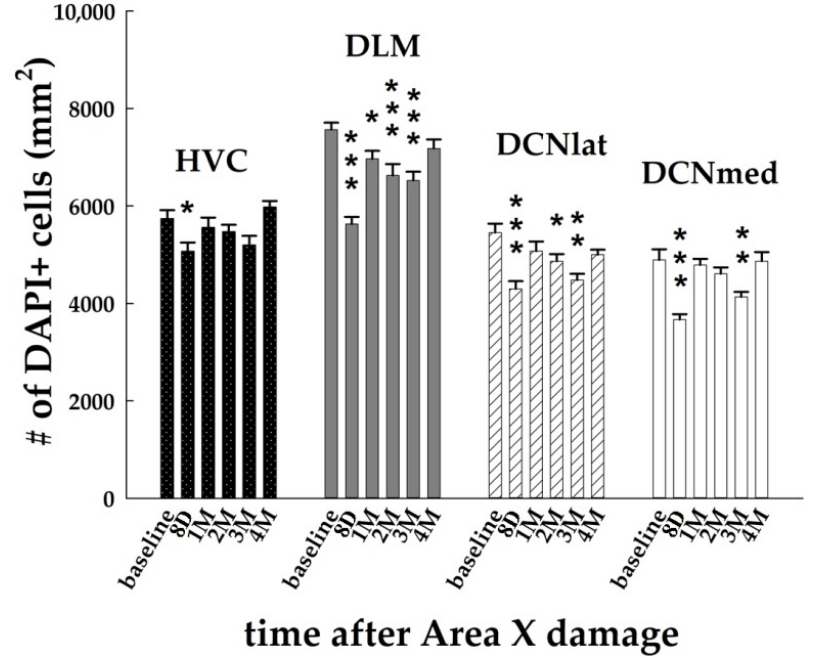
Figure 2. Quantification of the DAPI+ nuclei after Area X lesion in HVC, DLM, DCNlat, and DCNmed. Each bar represents mean and SEM. Two-way ANOVA was followed by the Holm–Sidak test with multiple comparisons vs. baseline group. * p < 0.05, ** p < 0.01, *** p < 0.001.